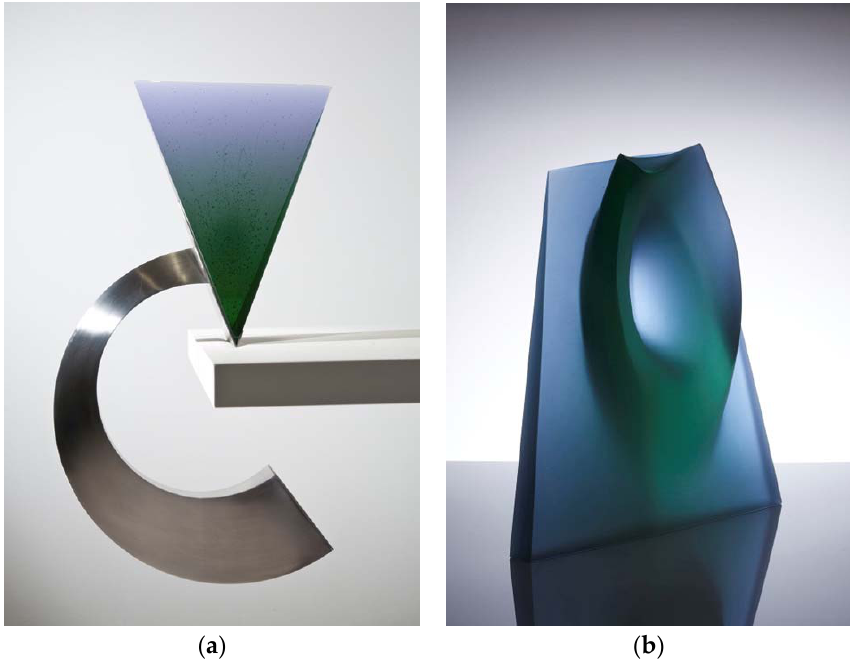
Figure 3. Bullseye 1844 Lavender Green shift glass showing a change in hue. ( a ) Heike Brachlow, Equinox I, 2011, cast glass, stainless steel, lead, dimensions 70 × 42 × 13 cm, photograph by Roger Lee, courtesy of the artist. ( b ) Ashraf Hanna, Lavender Green Form, cast glass, dimensions 38 × 35 × 9 cm, photograph by Ester Segarra, courtesy of the artist.